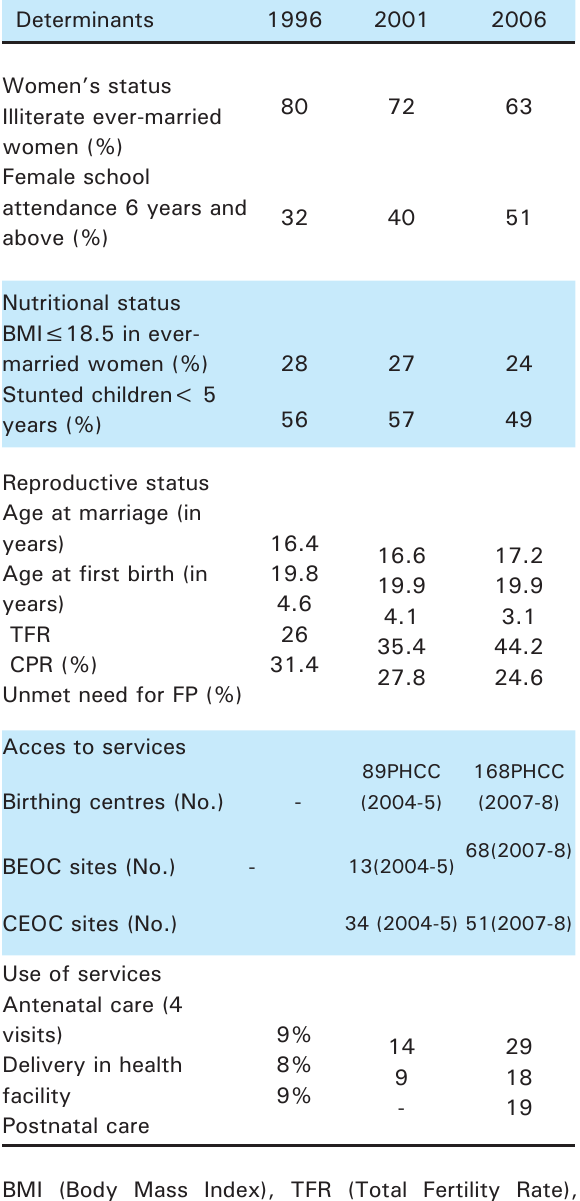
Table 1. Progress on various determinants of MMR